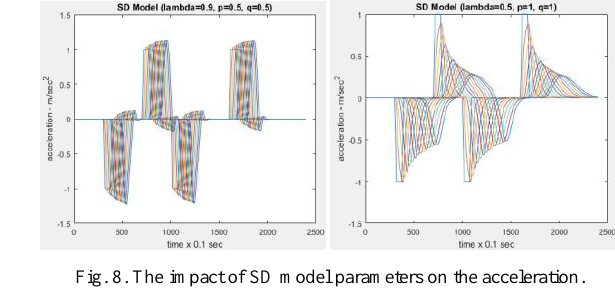
Fig. 8. The impact of SD model parameters on the acceleration.